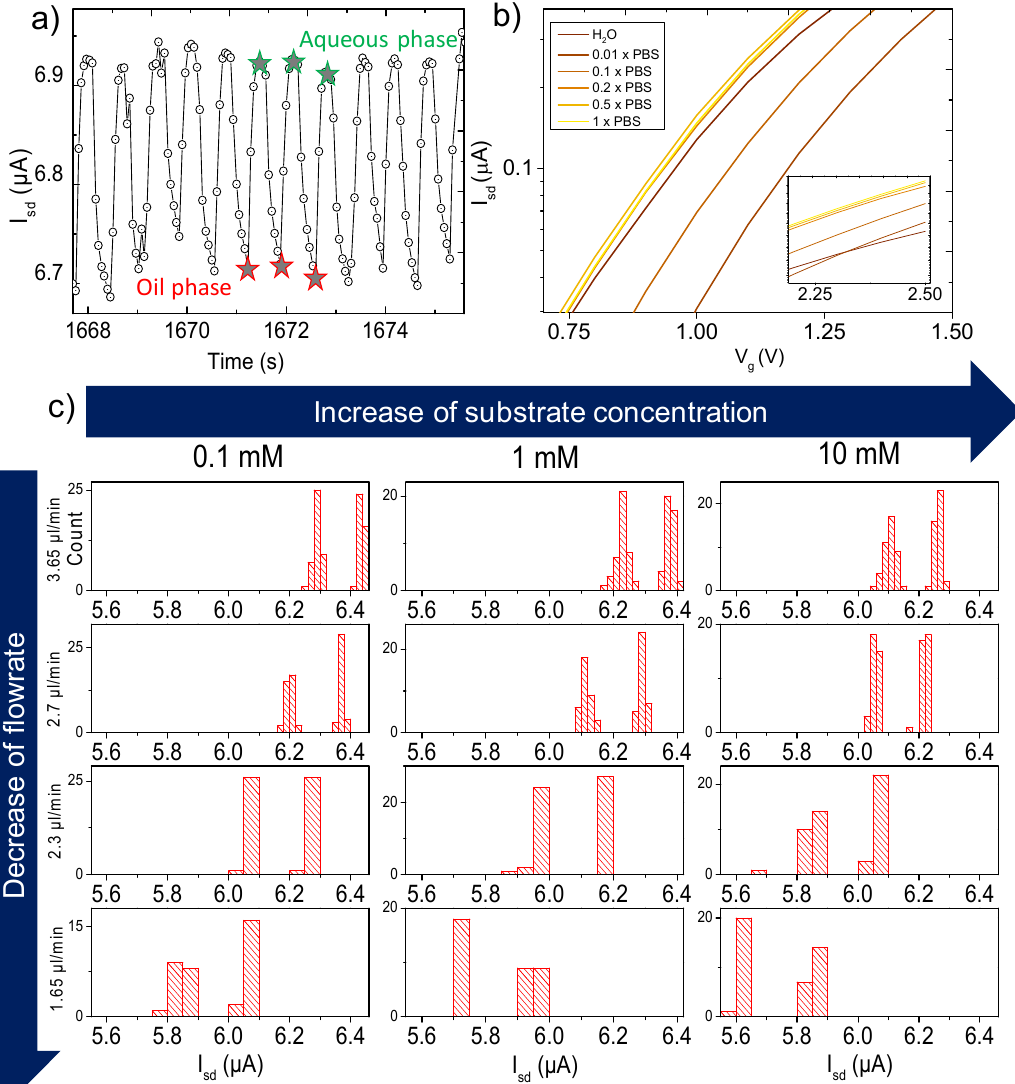
Figure 3. FET response to variations in sample composition. ( a ) I sd signal change with passing droplets. Local maxima correspond to every single droplet, while minima correspond to the oil separating them. ( b ) Transfer characteristics response to phosphate-buffered saline (PBS) buffer ionic strength variations. The calibration of the flow-rate test is shown in ( c ).